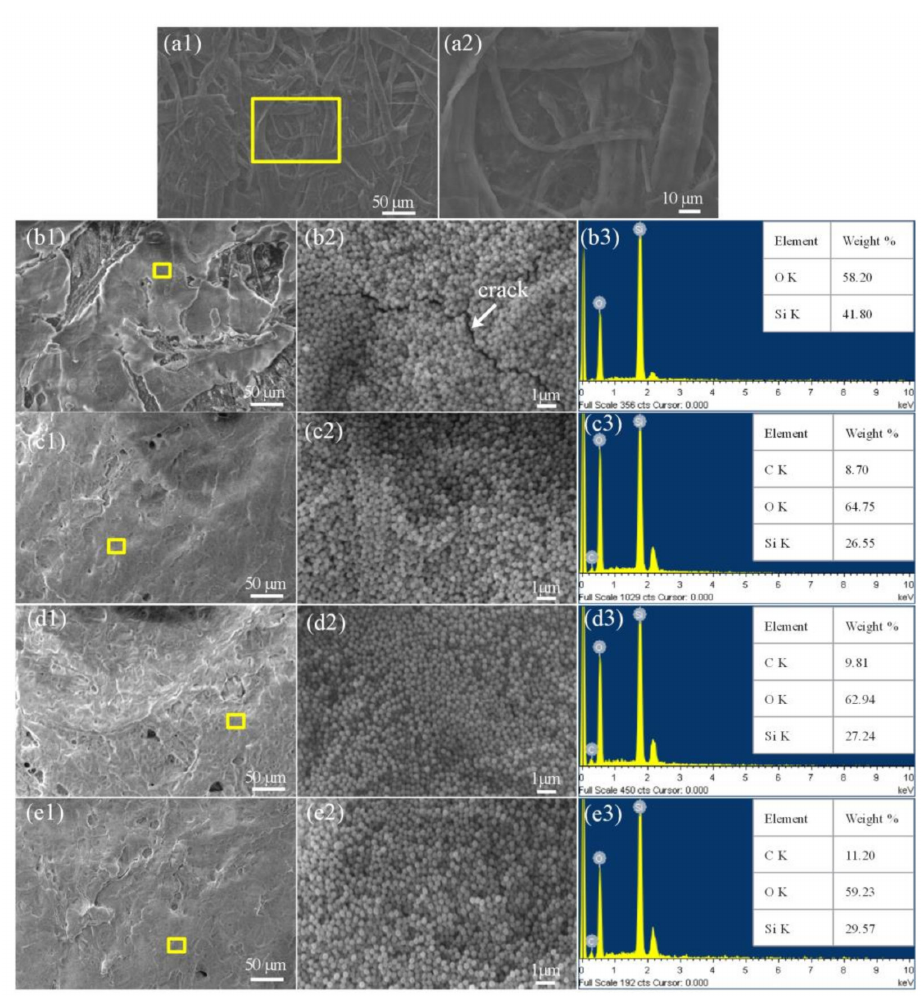
Figure 5. ( a ) Surface morphology of kraft paper from SEM observation with magnification of ( a1 ) 300 × and ( a2 ) 1000 × . ( b – e ) SiO 2 , SiO 2 /PMB, SiO 2 /PMB/GO and SiO 2 /PMB/RGO PSPs, respectively. ( b1 – e1 , b2 – e2 ) surface morphology with magnification of ( b1 – e1 ) 300 × and ( b2 – e2 ) 10,000 × . ( b2 – e2 ) represents the zoom-in area of the yellow frame in ( b1 – e1 ). ( b3 – e3 ) Elemental analysis (C, O, Si) of SiO 2 , SiO 2 /PMB, SiO 2 /PMB/GO and SiO 2 /PMB/RGO